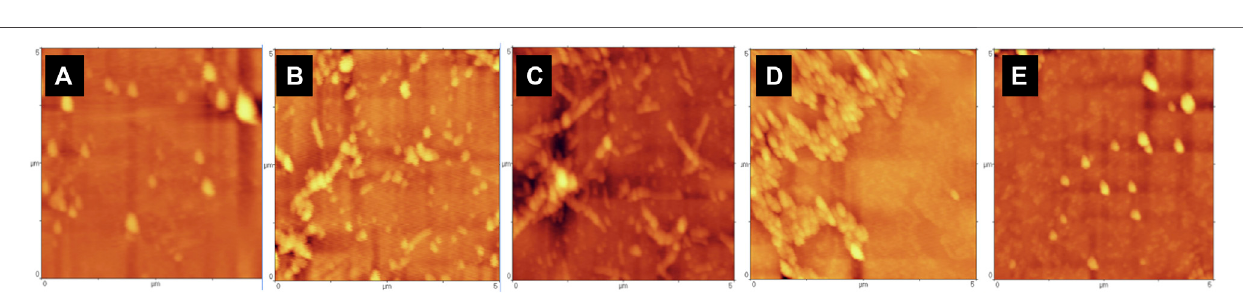
Frontiers in Pharmacology |